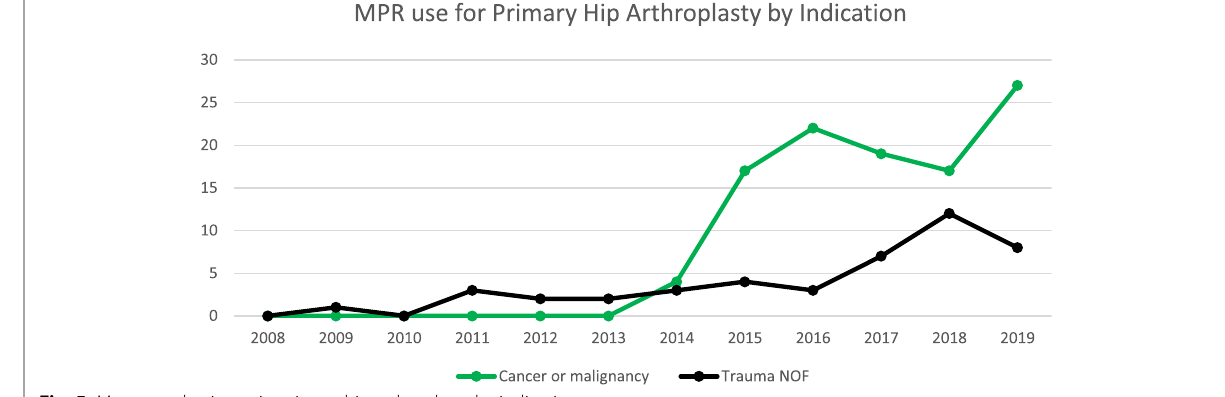
Fig. 5 Megaprosthesis use in primary hip arthroplasty by indication